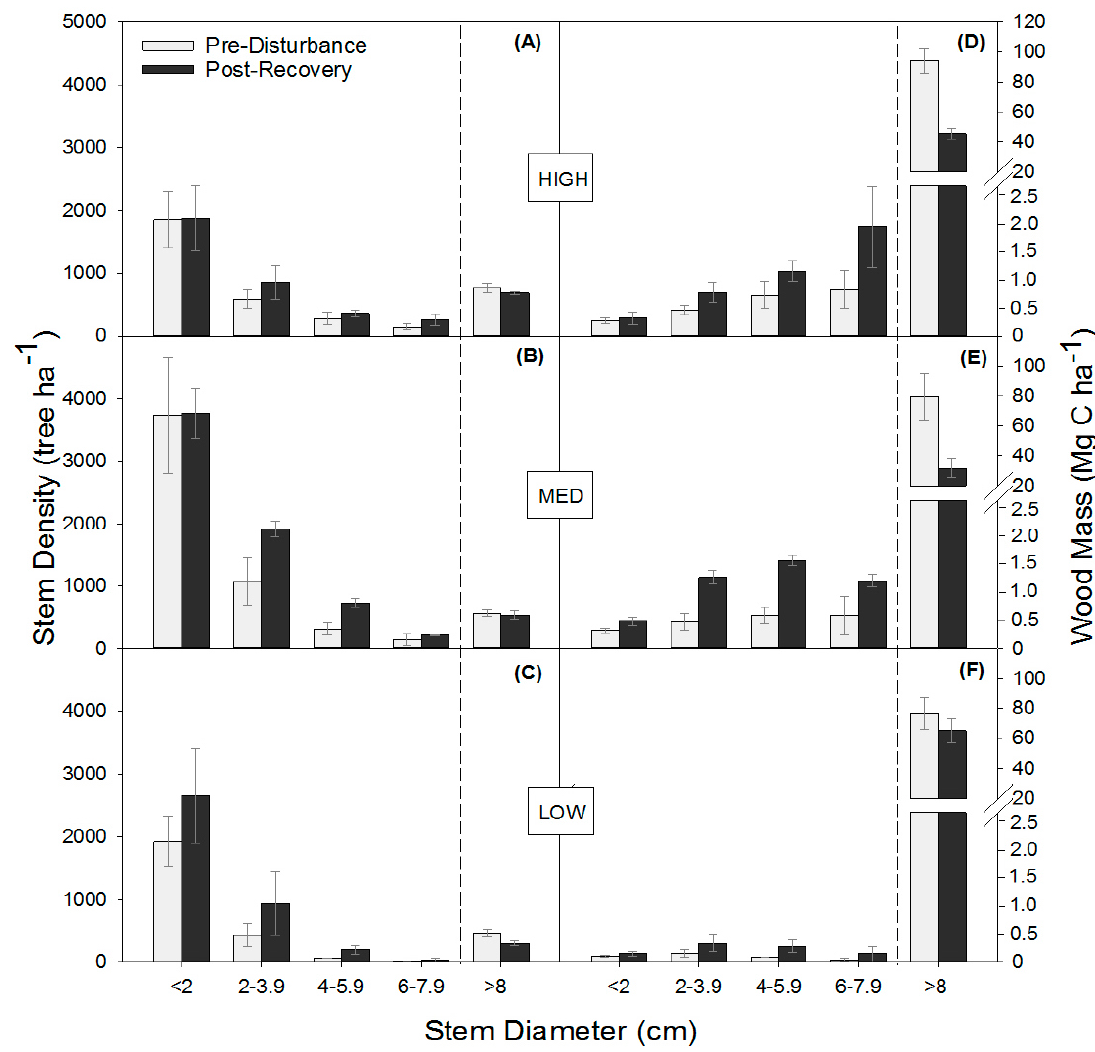
Figure 2. Tree stem density (trees per hectare) ( A – C ) and wood mass ( D – F ) (mean ± SE) distributions across stem diameter classes before (2001 or 2006) and following the recovery (2016) of experimental disturbance.